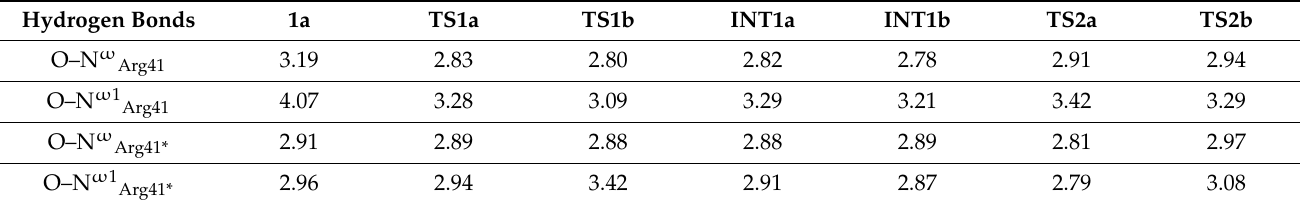
Table 4. The lengths of the hydrogen bonds between Arg41/Arg41* and C6=O in the reaction species. Hydrogen